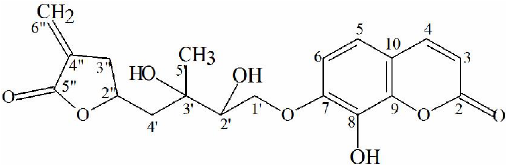
Figure 1. 8-Hydroxyisocapnolactone-2  3 